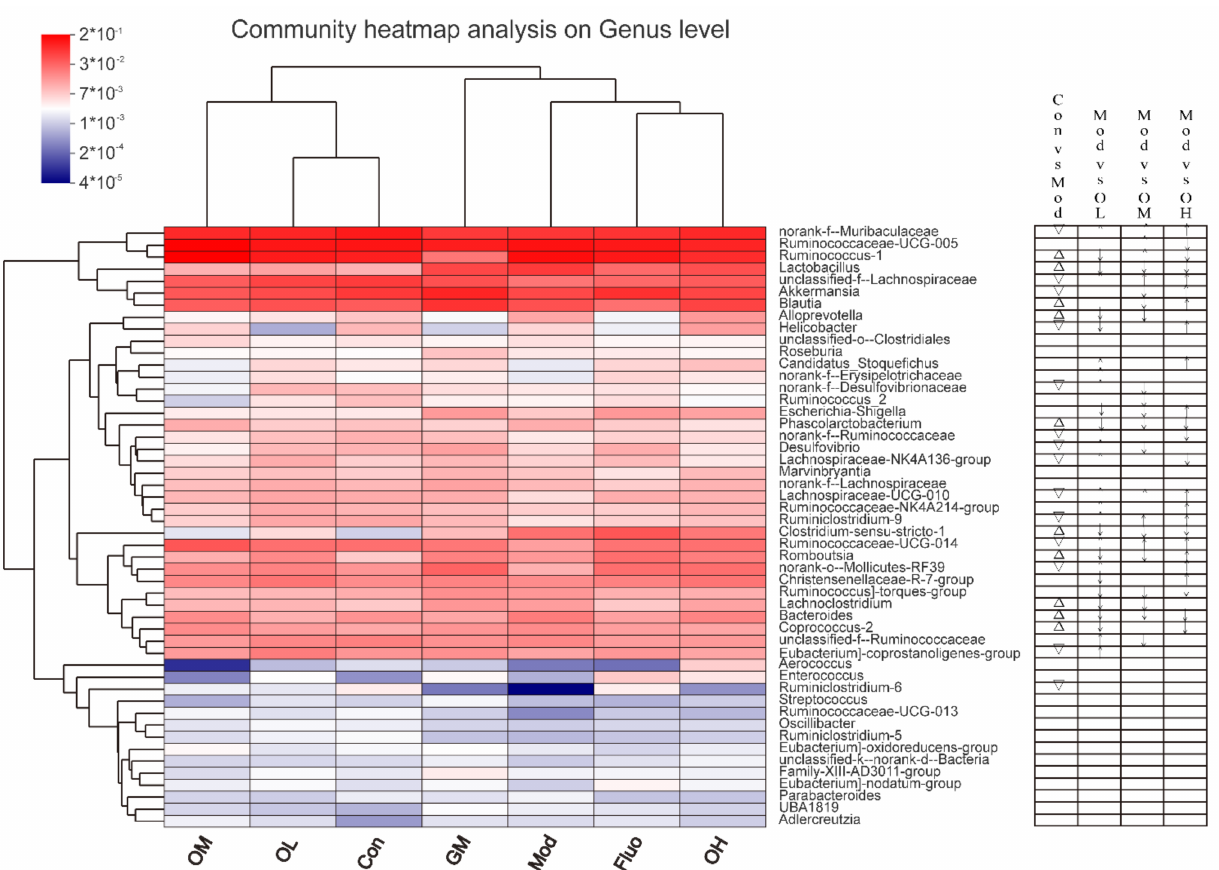
Figure 7. The compositions of gut microbiota were altered after jasmine tea administration. The relative abundance of the top 50 genera among different groups is shown in the heatmap. The relative abundances are presented by the color of the squares. The similarities of abundance among genera or samples are indicated by hierarchical clustering. The arrows ( ↑ ) and ( ↓ ) represent that the relative abundance of different genera was significantly up-regulated and down-regulated after the intervention of different doses of jasmine tea compared with the model group. The down-triangle ( (cid:53) ) and up-triangle ( ∆ ) represent that the relative abundance of different genera was significantly down-regulated and up-regulated after the CUMS intervention compared with the control